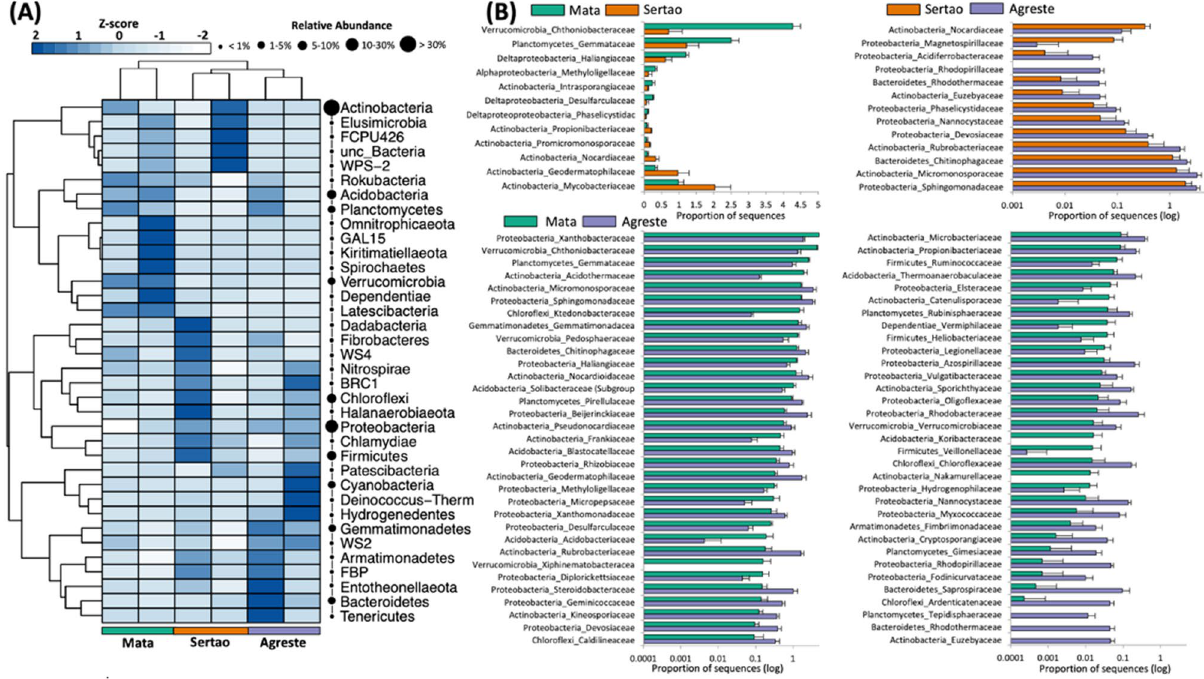
Figure 2. Bacterial composition in soils along three distinct ecoregions under cowpea cultivation based on the 16S rRNA gene. ( A ) Heatmap showing the differential abundance of phyla among the sites. The color key relates the heat map colors to the standard score (z-score), i.e. the deviation from row mean in units of standard deviation above or below the mean. The circles are proportional to the relative abundance of each phylum in all samples. ( B ) Scatter-plot showing the differential abundance of family among regions based on Welch’s t-test with Benjamini–Hochberg correction constructed in STAMP ( P <